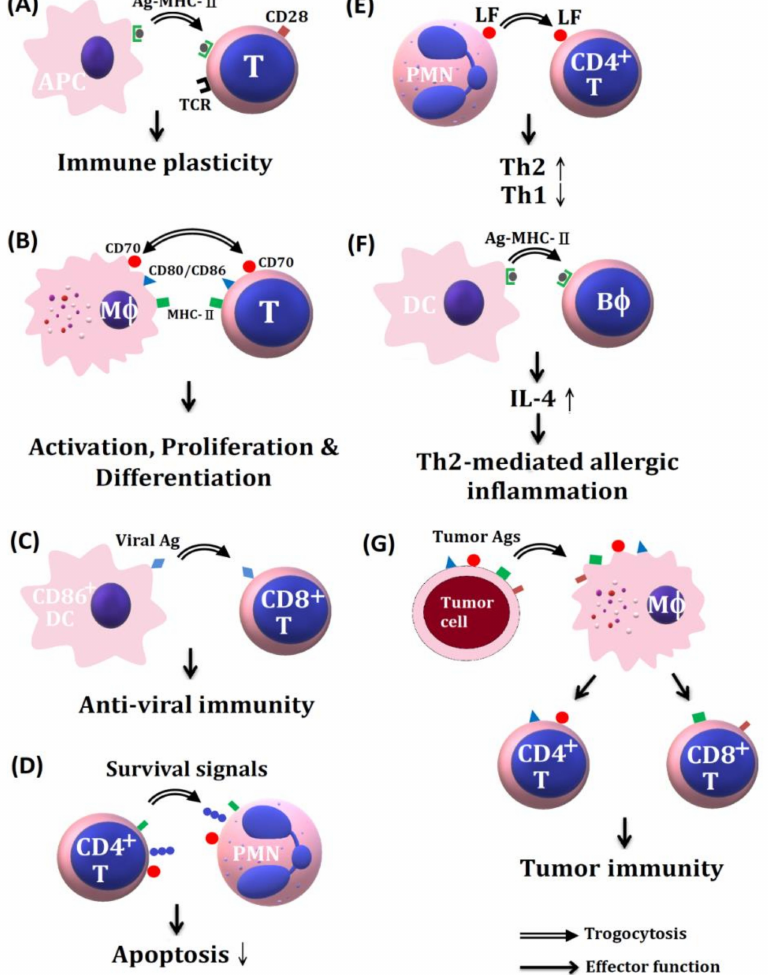
Figure 2. The trogocytosis of various membrane molecules between different innate and adaptive immune cells or tumor cells in mediating a variety of effector function. ( A ) Trogocytosis of antigen- MHC II complex from APC to TCR on T cells in inducing immune cell plasticity. ( B ) The transfer of MHC II and CD80/86 molecules from macrophages to T cells sustains T cell activation, proliferation, and differentiation. ( C ) The transfer of viral antigens from CD80+ DC to CD8+T cells can induce anti-viral immunity. ( D ) CD4+T cells transfer survival signals to PMN in suppressing PMN apoptosis. ( E ) The transfer of lactoferrins from PMN to CD4+T cells can skew CD4+ T cells toward Th2 immune responses. ( F ) The transfer of antigen-MHC II complex to basophils can enhance IL-4 production inducing Th2-mediated allergic reaction. ( G ) The transfer of tumor-specific antigen from tumor cells to macrophages and then distributes to both CD4+T and CD8+ T to mediate tumor cytotoxicity. Ag-MHC: antigen conjugated-major histocompatibility complex, APC: antigen-presenting cell, DC: dendrite cell, PMN: polymorphonuclear neutrophil, LF: lactoferrin, B φ : basophil, M φ :